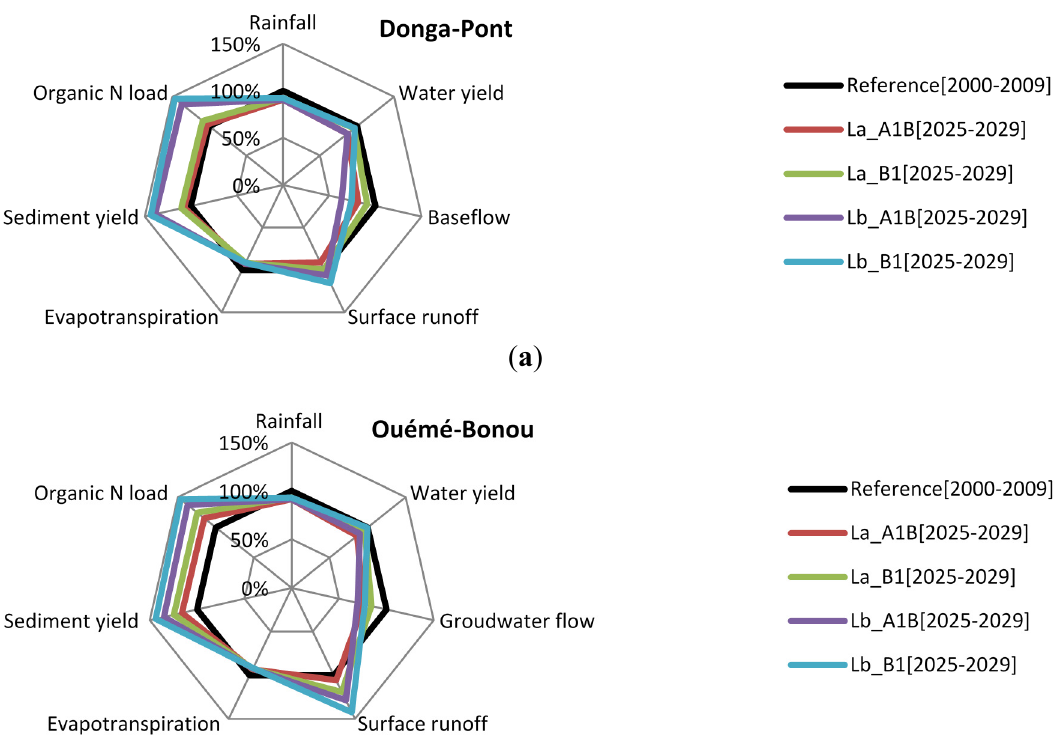
Figure 14. Simulated trends under land use and climate scenarios (2025 to 2029). ( a ) Donga-Pont; ( b )